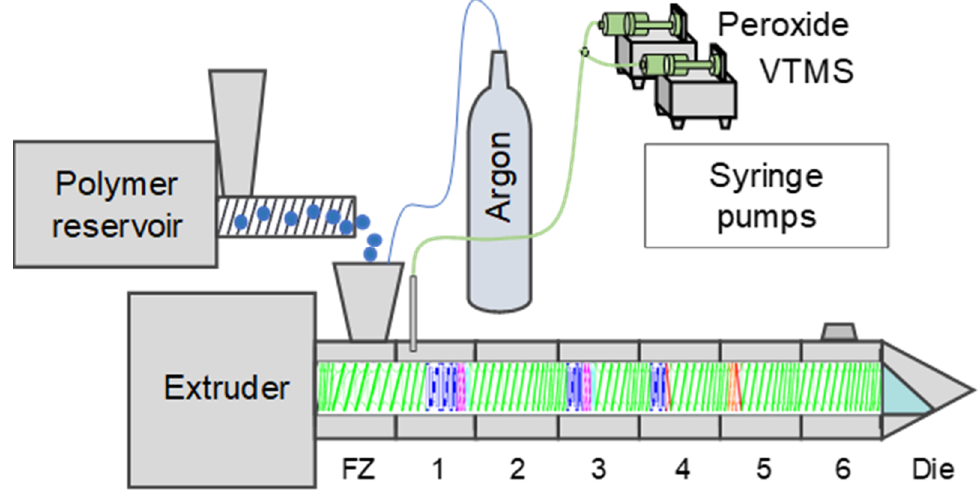
Figure 2. Schematic reactive extrusion setup with feeding arrangement.